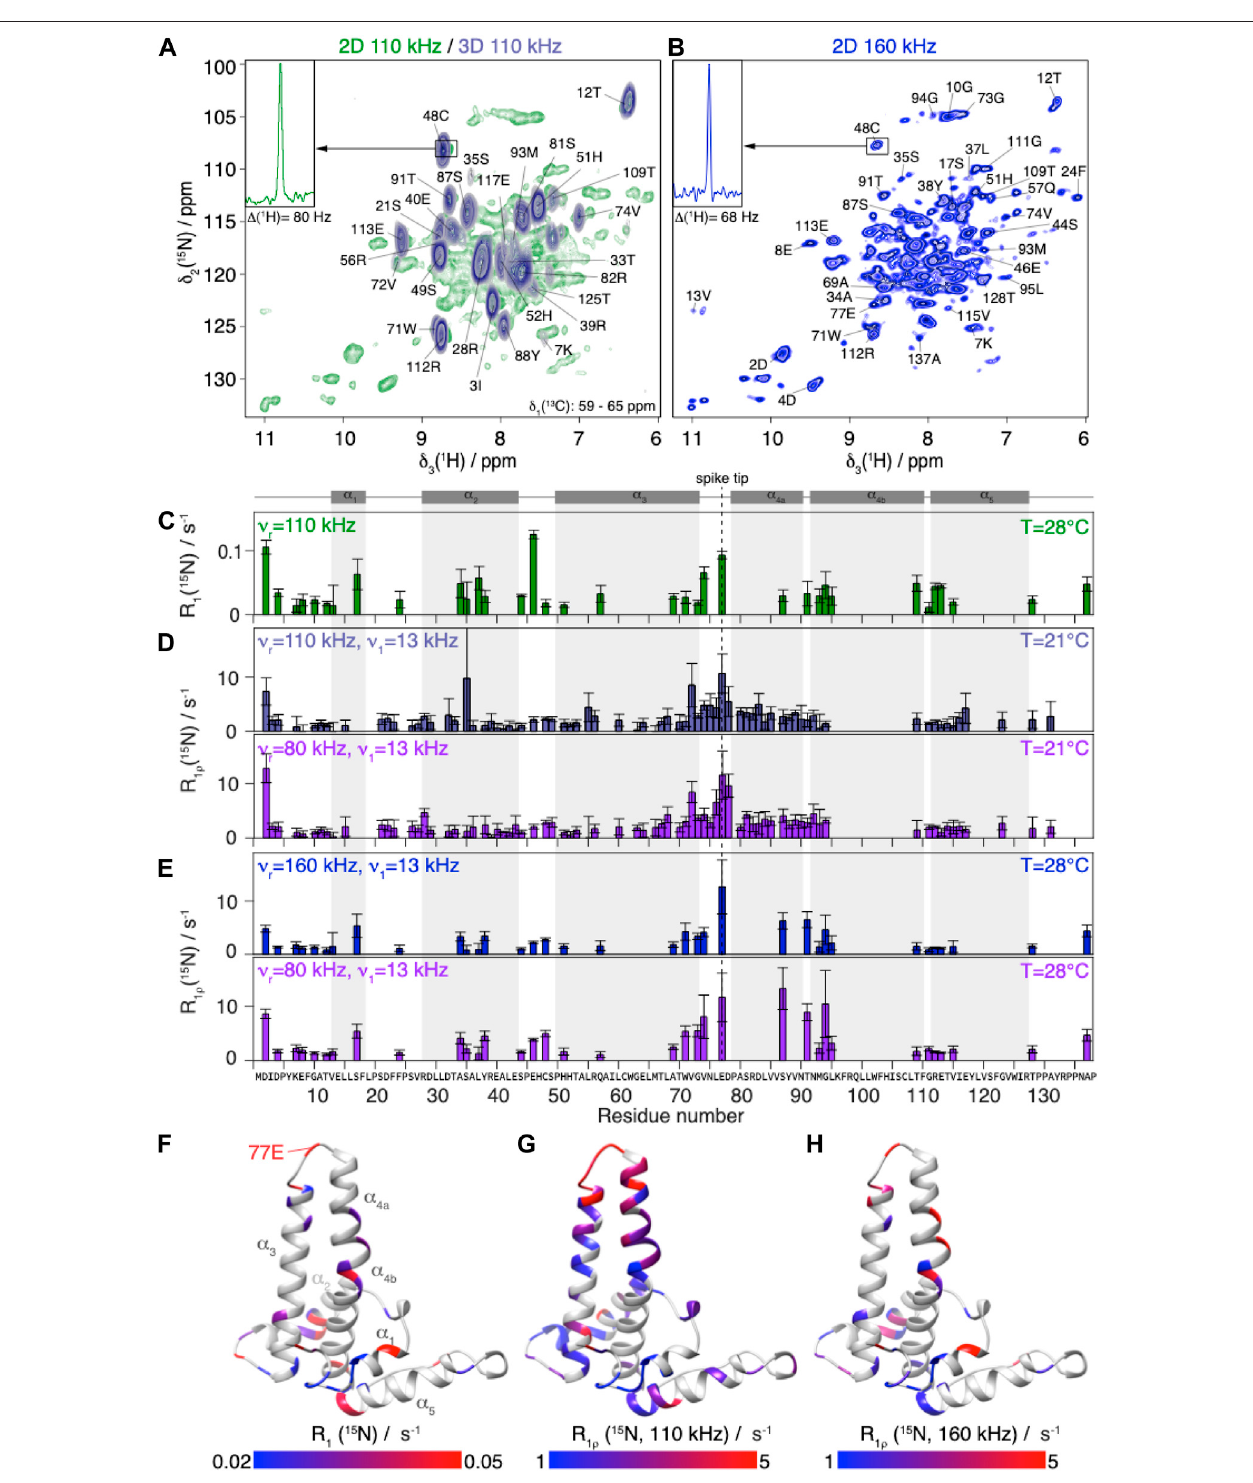
FIGURE 2 | NMR 15 N relaxation-rate constants of Cp149 capsid. (A) Overlay of Cp149 2D hNH spectrum (green) and slices of 3D hCANH ( δ (13C) from 58.95 to 65.51 ppm, steel blue) recorded at 110 kHz MAS. The proton line of48C in the 2D spectrum is shown in the insert. (B) 2D hNH spectrum of Cp149 capsids recorded at 160 kHz MAS. The proton line of 48C is shown in the insert. The assignment is transferred from Lecoq et al. (Lecoq et al., 2019). Experimental site-speci fi c values of ( C) R 1 ( 15 N, 86 MHz) measured at 110 kHz, (D) R 1 ρ ( 15 N) measured at 110 kHz (steel blue) and 80 kHz (purple) MAS using ] 1 (cid:1) 13 kHz spin-lock with the 3D hCANH in the 0.7 mm rotor and (E) R 1 ρ ( 15 N) measured with 2D hNH at 160 kHz (blue) and 80 kHz (purple) MAS in the 0.5 mm rotor using ν 1 (cid:1) 13 kHz spin-lock. The error bars